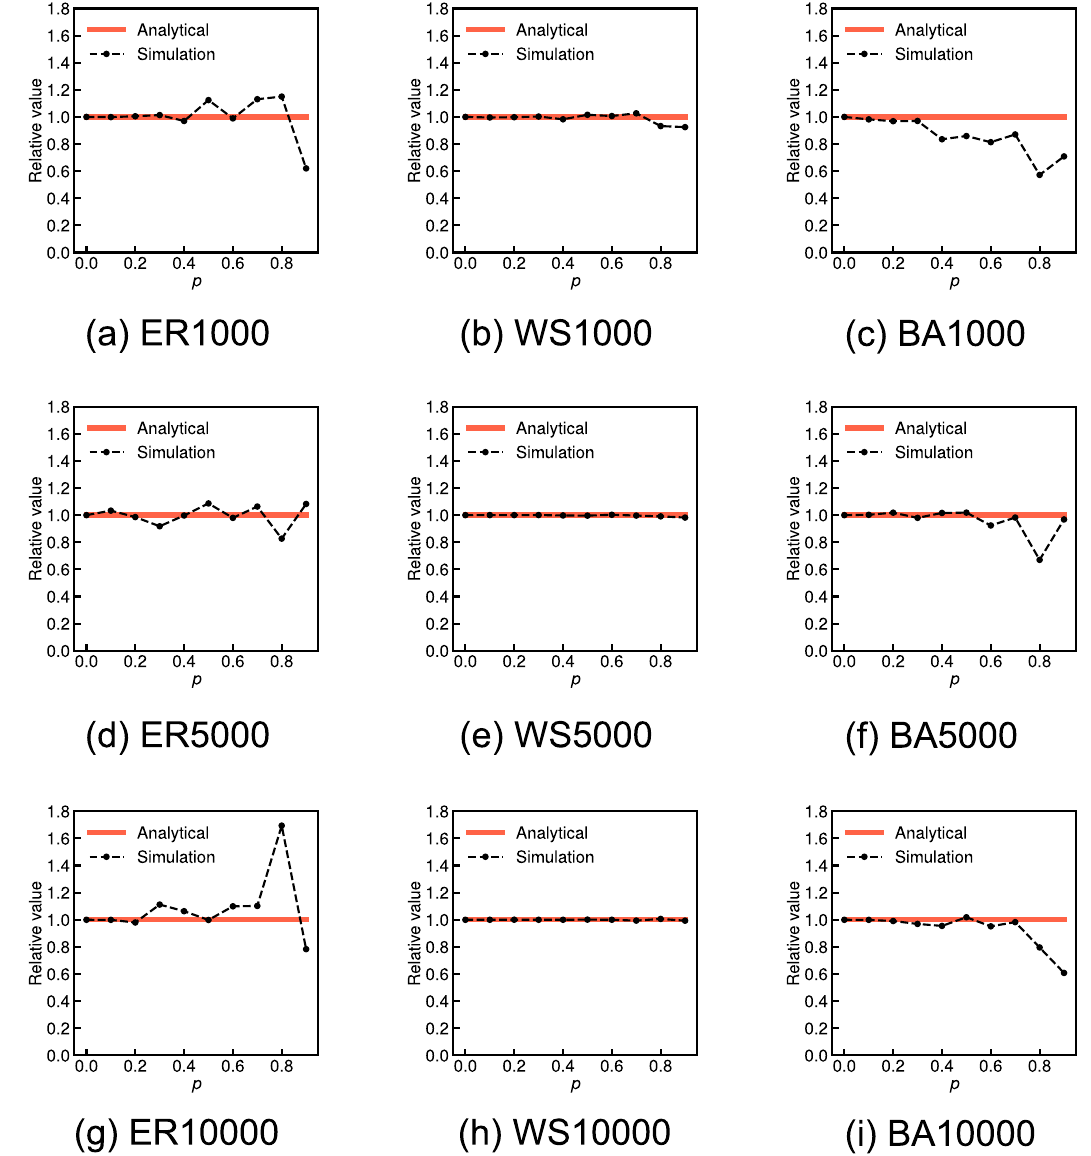
Figure 2. Comparison of the analytical and simulation results for the relative global clustering coefficient when each node is independently missing with probability p on ER, WS, and BA graphs for each 1000, 5000, and 10,000